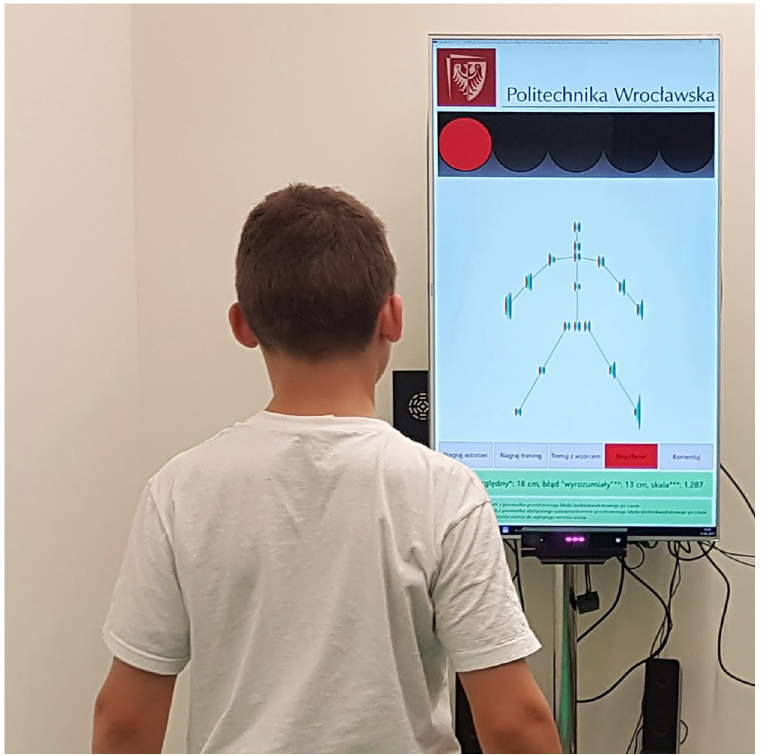
Fig 2. A young athlete training with the Kinect-based system. Graphical information displayed on the screen provides feedback (see text). The parent of the young individual depicted in the figure has given written informed consent (as outlined in the PLOS consent form) to publish these case